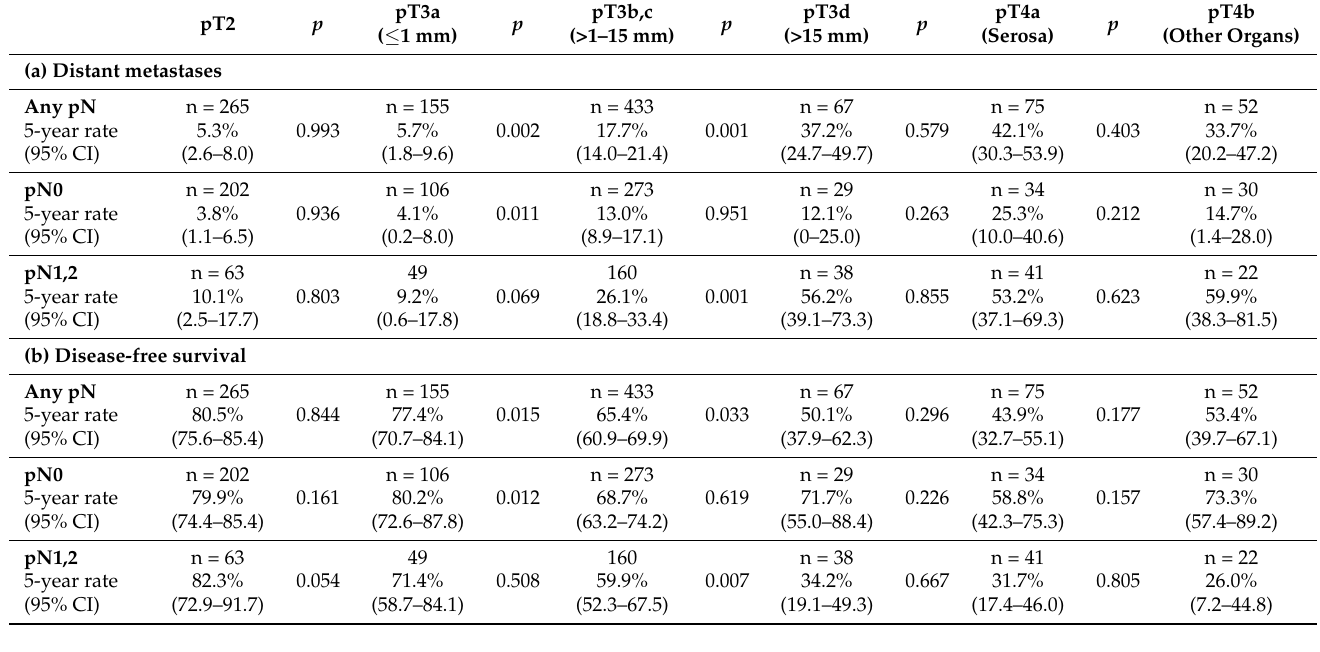
Table 3. Distant metastases and disease-free survival (n = 1047).